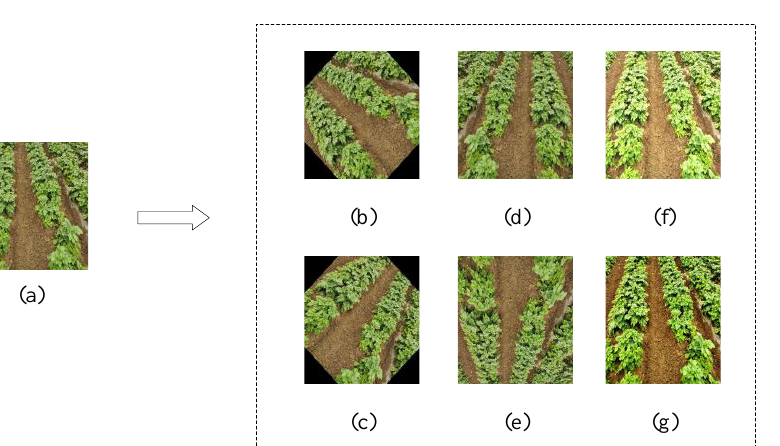
( c ) Figure 7. ROI settings: ( a ) original image; ( b ) ROI; ( c ) binary image mask. 2.4.2. Crop Row Feature Point Extraction After semantic segmentation and ROI setting, a binary map mask with only two lines in the field of view is obtained. Crop row feature point extraction is needed to determine the crop row ’ s position by identifying the white connected domain as a set of feature points with precise coordinates. In this paper, a scanning method was used to determine the location of white-connected regions. The more times you scan, the more reference points you collect, and the more precise your navigation line fitting is. The computational load will be increased if there are too many reference points. As a result, in this study, we employed the interlaced scanning method to extract edge feature points.